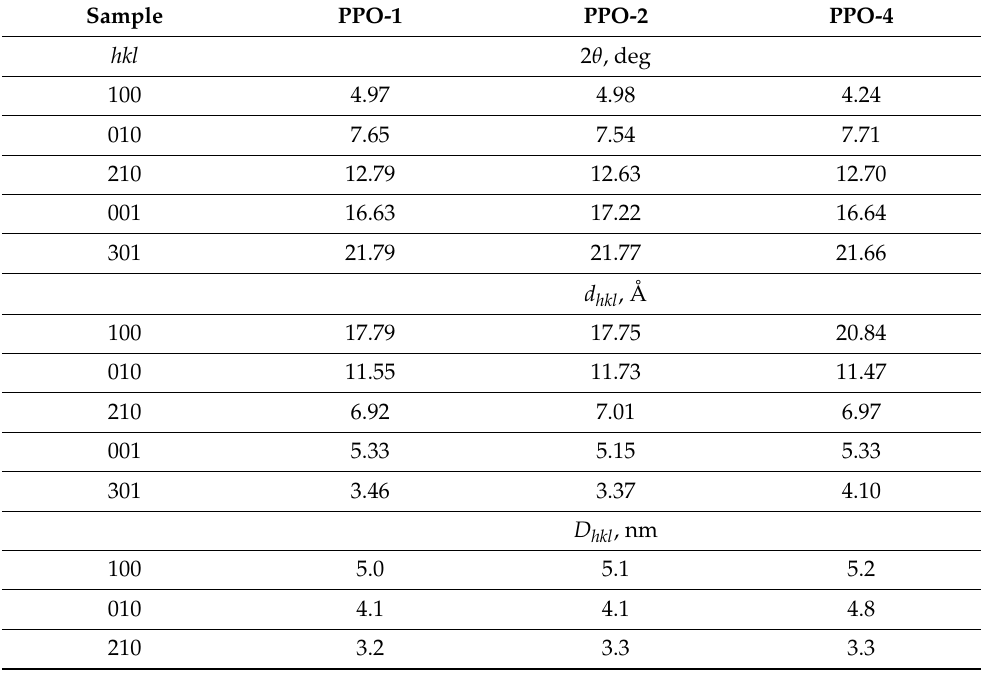
Table 1. Angular positions of diffraction peaks, their corresponding d-spaces ( d hkl ), crystallite sizes ( D hkl ), relative peak intensities ( I hkl ), and crystallinity degrees (C I ), for PPO-1, PPO-2, and PPO-4